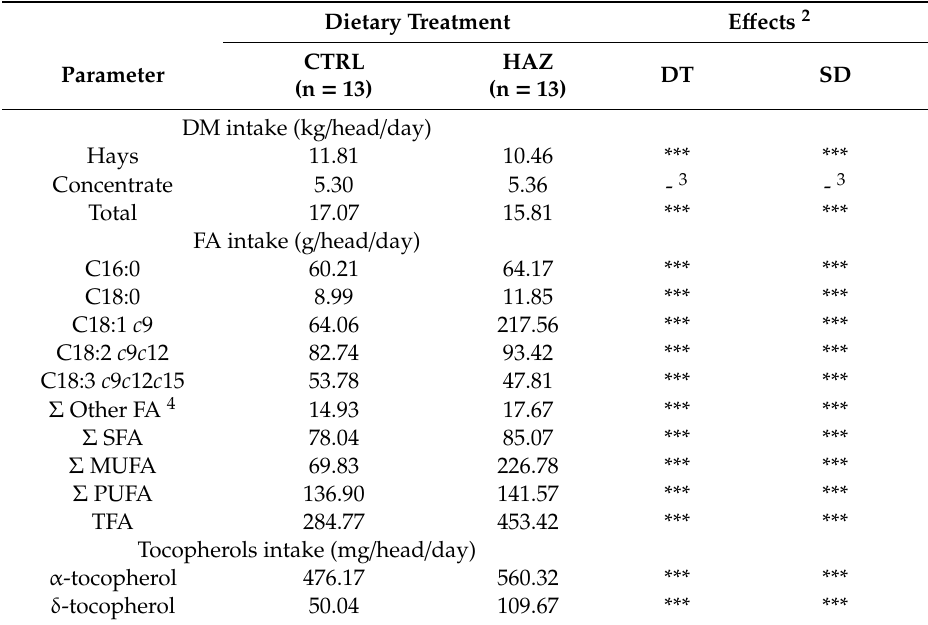
Table 2. Dry matter, main fatty acids, and tocopherols intakes of cows fed the control (CTRL) and hazelnut skin (HAZ) diets 1 . Dietary Treatment E ff ects 2